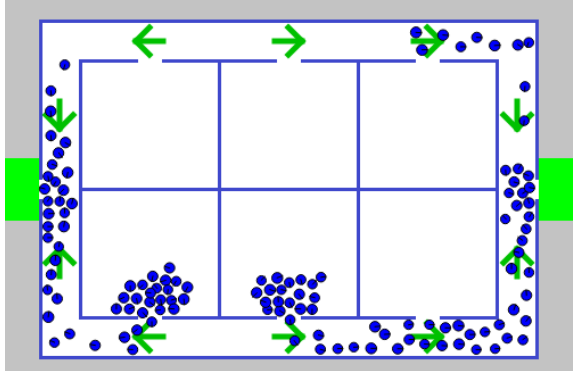
Figure 4. Simulation